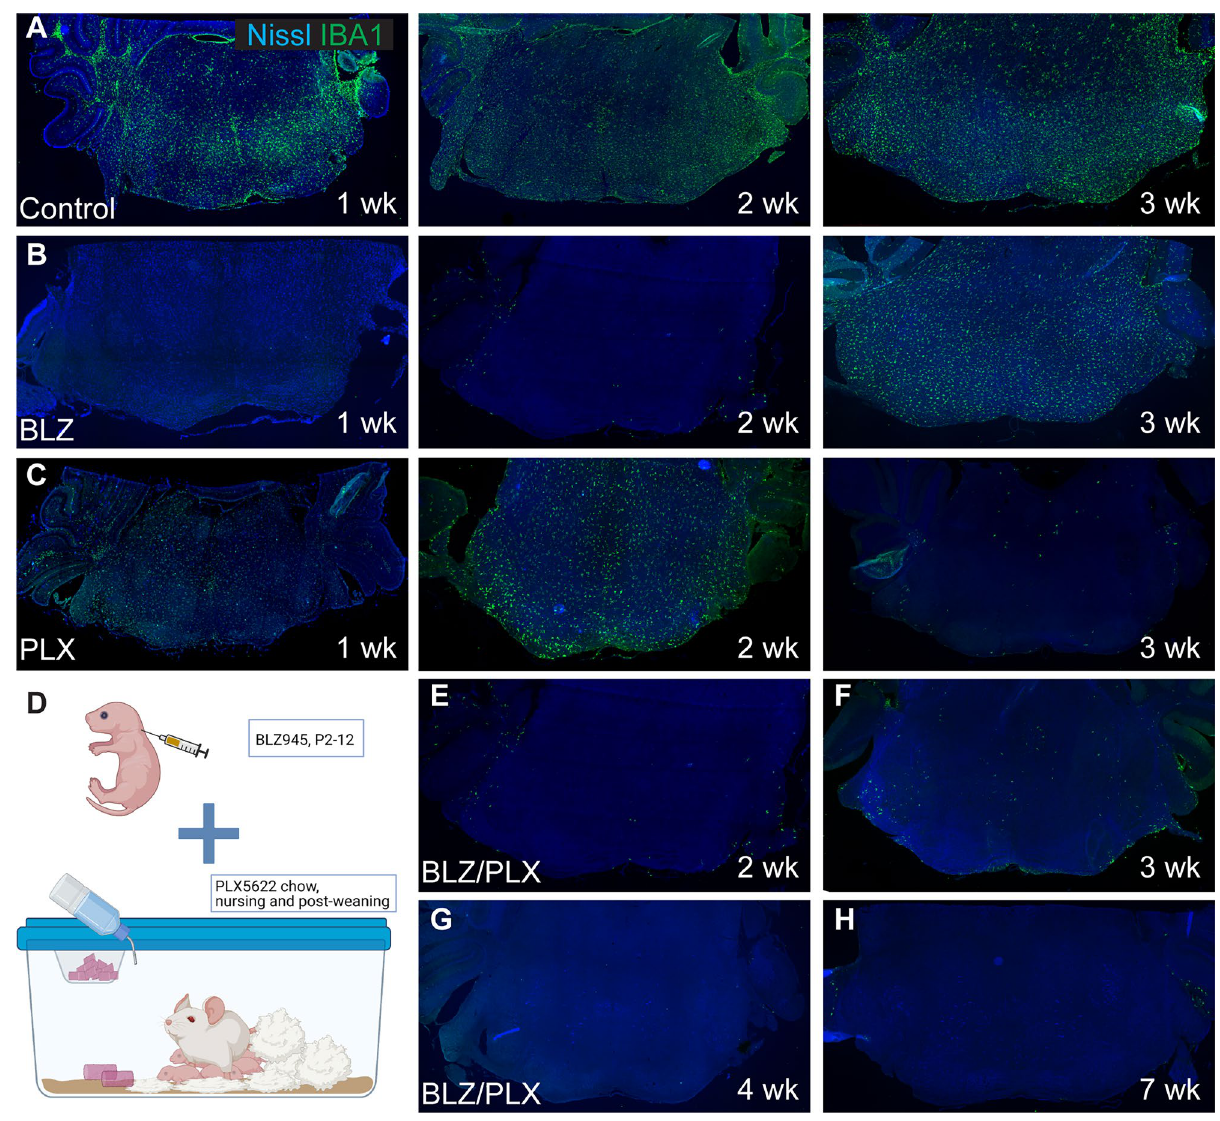
Figure 1. Long-term microglial depletion with CSF1R inhibitors. ( A ) Coronal brainstem section from a one-week-old (1 wk) control mouse with Nissl (blue) and microglial marker IBA1 (green) immunolabeling. Microglia are dispersed throughout the brainstem and are abundant by 2 wk. At 3 wk microglia remain distributed throughout the brainstem. ( B ) Brainstem sections from 1 wk, 2wk, and 3 wk mice treated every other day with BLZ945 (BLZ). At 1 and 2 wk, microglia are depleted. At 3 wk, microglia repopulated the brainstem despite continued BLZ treatment. ( C ) IBA1 immunolabeled section from a 1 wk mouse that received PLX5622 (PLX) through lactation beginning on P2. At 1 and 2 wk following lactation mediated PLX treatment, microglial are present throughout the brainstem but at lower cell density compared to controls. At 3 wk, pups are weaned and consume the PLX chow directly, resulting in microglial elimination with only a few IBA1 + cells detected. ( D ) Illustration of a dual drug method which involved subcutaneous BLZ injections and PLX treatment through the nursing dam. Created with BioRender.com. ( E ) – ( H ) Nissl and IBA1 immunolabeled sections from BLZ/PLX treated mice at 2, 3, 4, and 7 wk, respectively. Microglia were eliminated and did not return within the ages